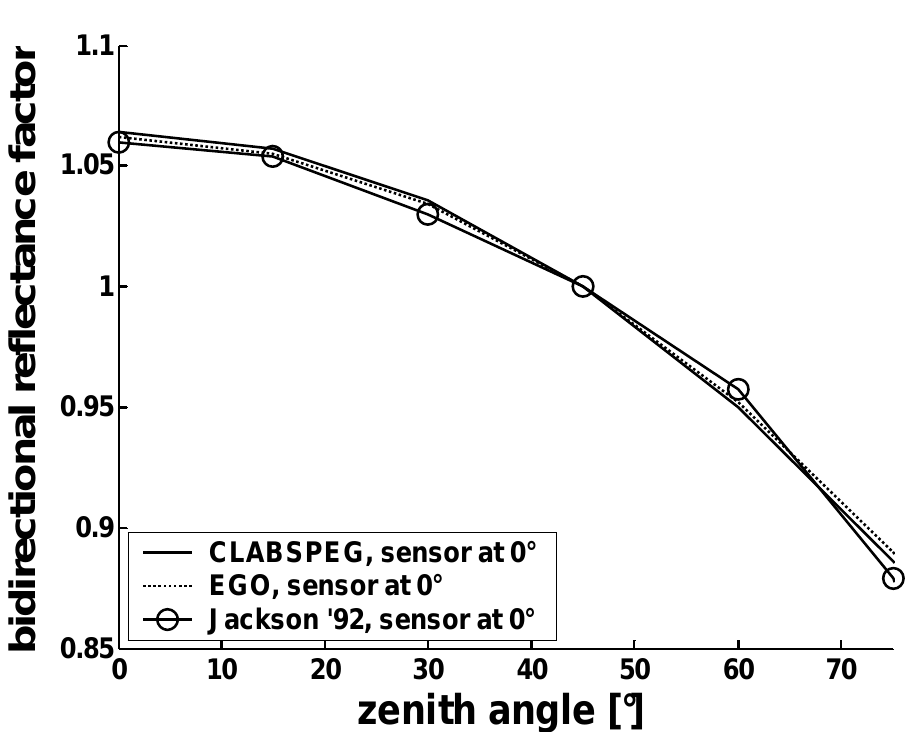
Figure 4 . Bidirectional Reflectance Factors of the Spectralon for 3 different settings: 1) = 0° at 650 nm; 2) EGO Spectralon panel at 650 nm CLabSpeG Spectralon panel with θ r measured by [28] with θ = 0°; and 3) average of 11 Spectralon panels at 655 nm r = 0°. The differences among the three polynomial equations measured by [36] with θ r presenting the Bidirectional Reflectance Factors are smaller than the standard deviation (0.0040 at 15° and 0.0076 at 75°) found by [36] among the 11 Spectralon panels.